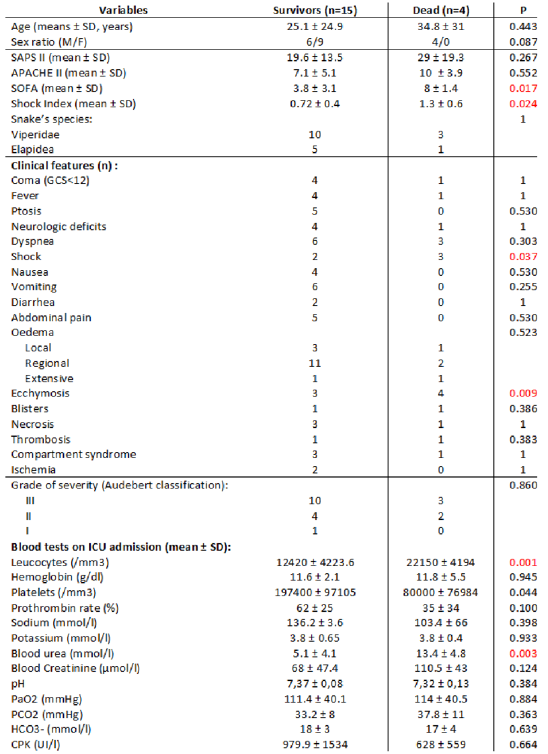
Table 1: Univariate analysis of predictors of mortality in snake envenoma- tion at admission in ICU. FC‑171 Acquired agitation in ARDS with Covid‑19 compared to influenza patients: a propensity score matching observational